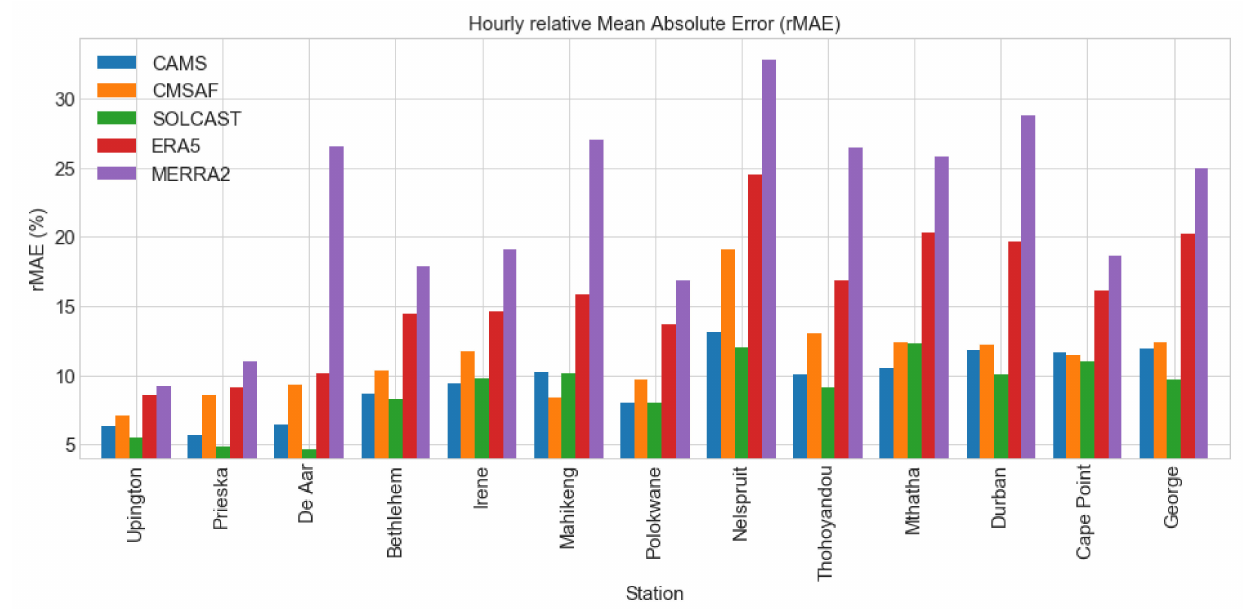
Figure 5. Hourly relative mean absolute error of gridded datasets against measured in situ